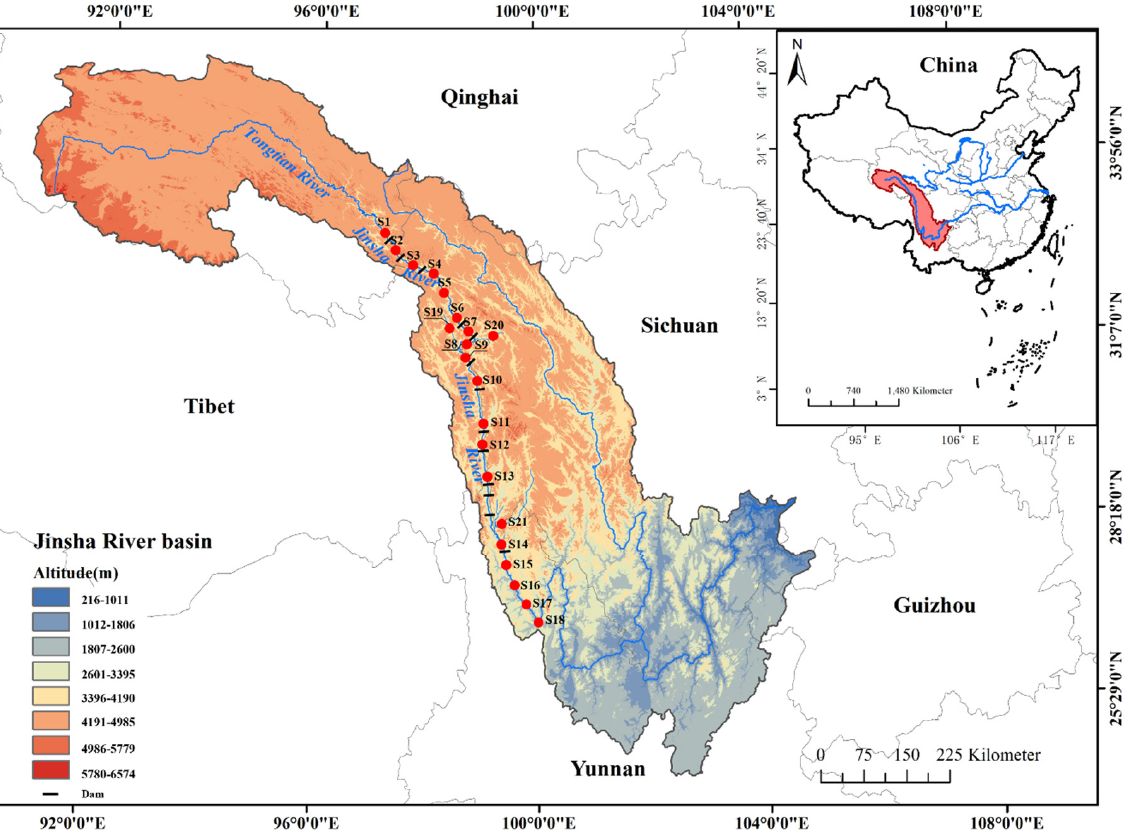
Figure 1. Map of sampling sites in the upper reaches of the Jinsha River.